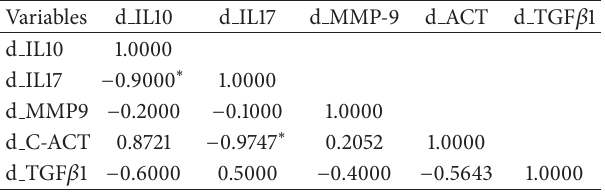
Table 7: Correlation analysis between changes of C-ACT scores